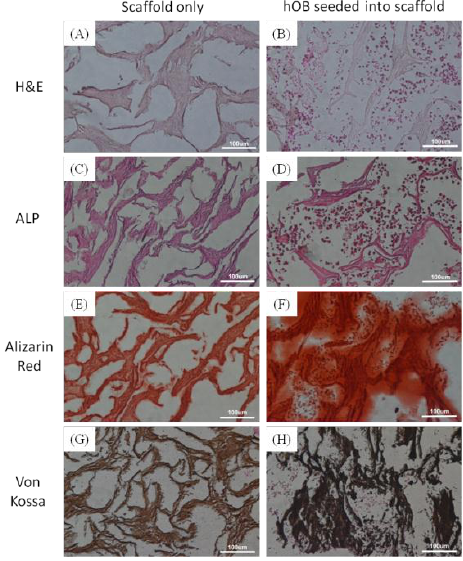
Figure 7. ( A , B ) H&E; ( C , D ) ALP; ( E , F ) Alizarin Red and ( G , H ) Von Kossa stained